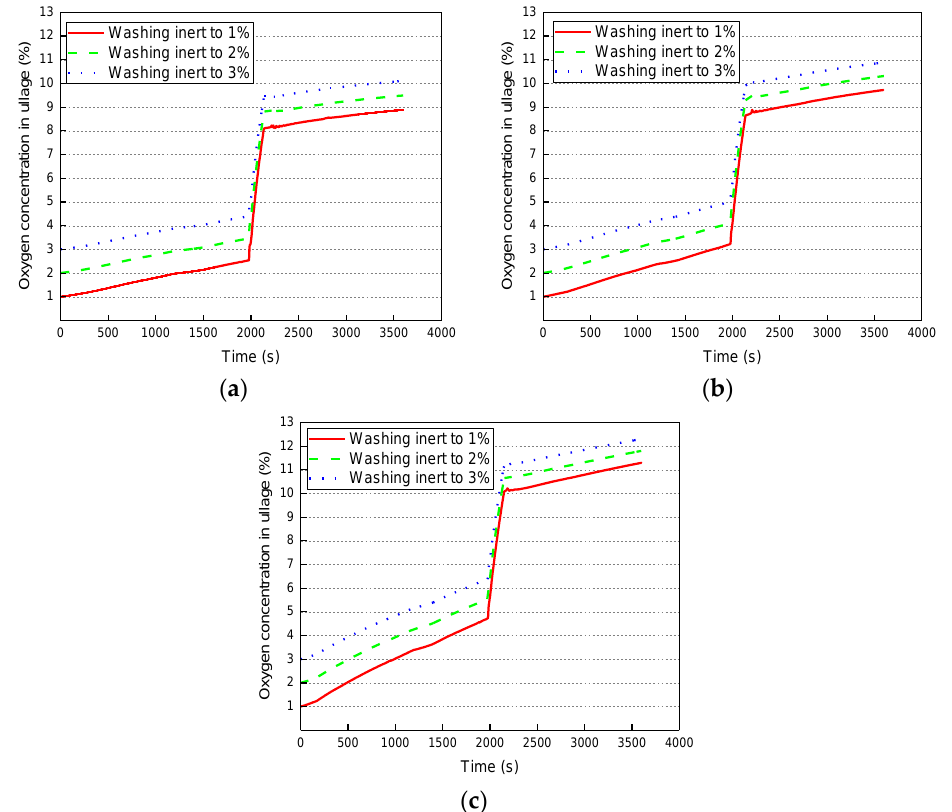
Figure 4. Variation in oxygen concentration in the ullage of the flight package; ( a ) initial fuel load 30%; ( b ) initial fuel load 50%; ( c ) initial fuel load 70%.